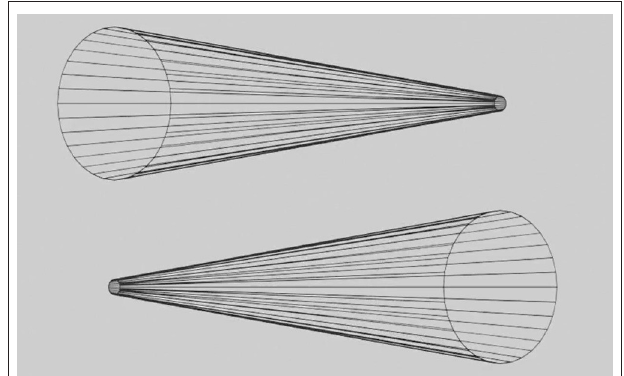
FIGURE 7 | Rotating cones. These wireframe cones rotate continuously around the vertical axis, but they appear to oscillate back and forth over a 180-degree range like the Ames window. Please see Supplementary Video 7 for an